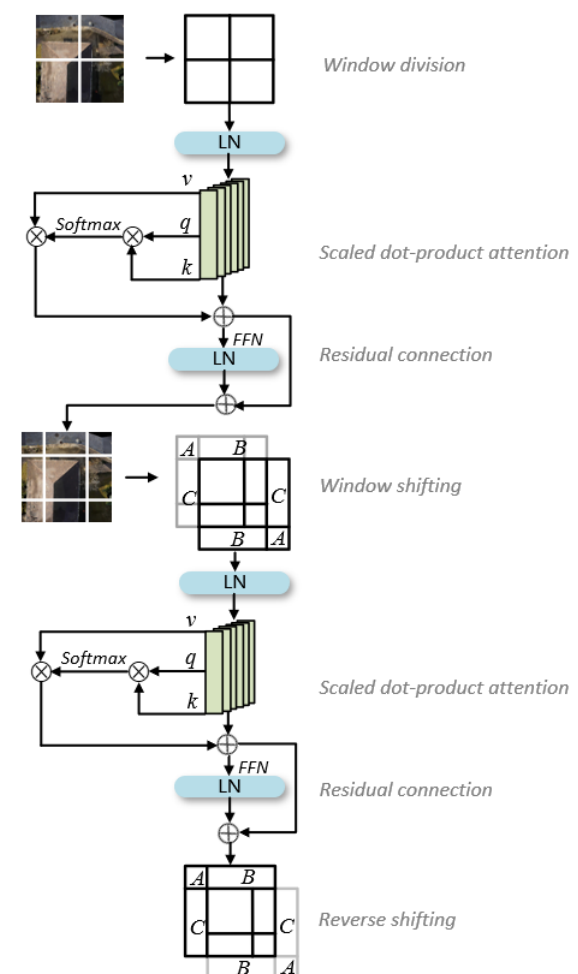
Figure 3 . Structure of a single-layer swin-Transformer